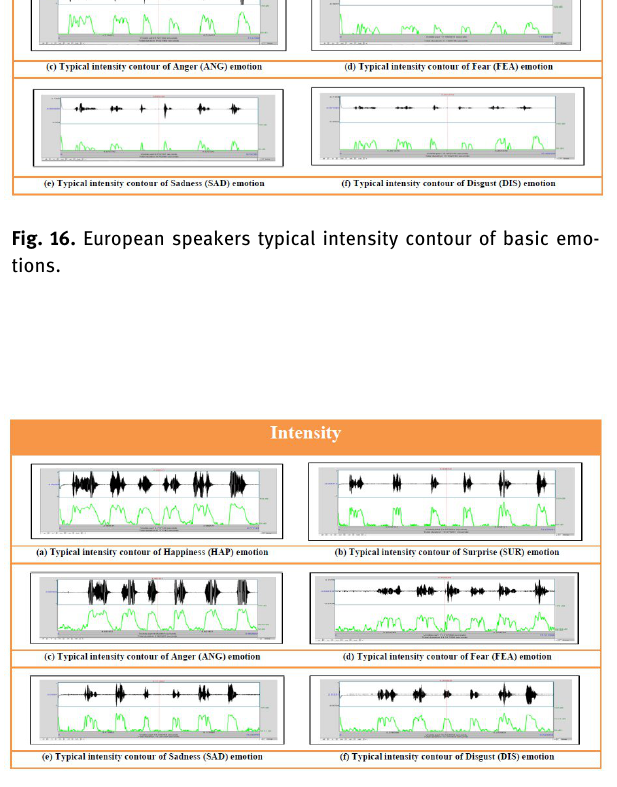
Fig. 17. Asian speakers typical intensity contour of basic emotions.